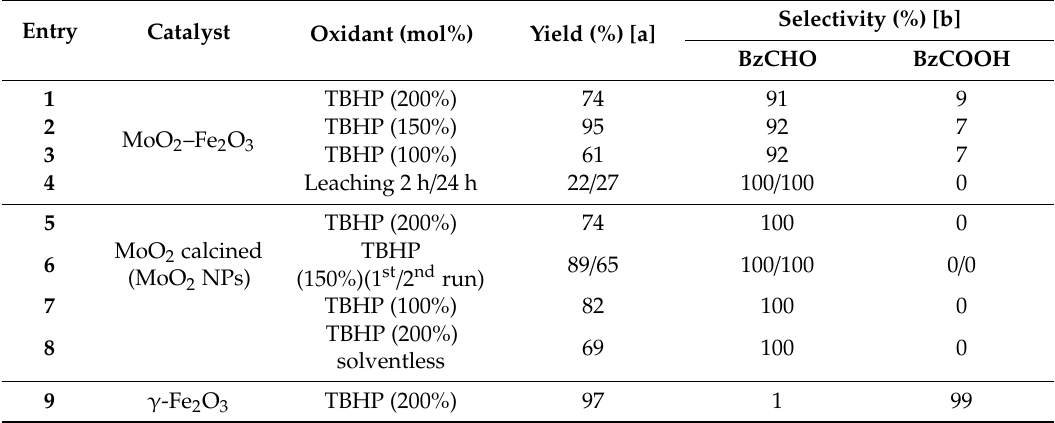
Table 1. Results from benzyl alcohol oxidation with tert -butyl hydroperoxide (TBHP) as